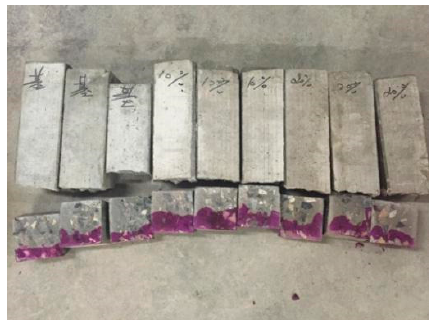
Figure 3. Determination carbonation depth of specimens.